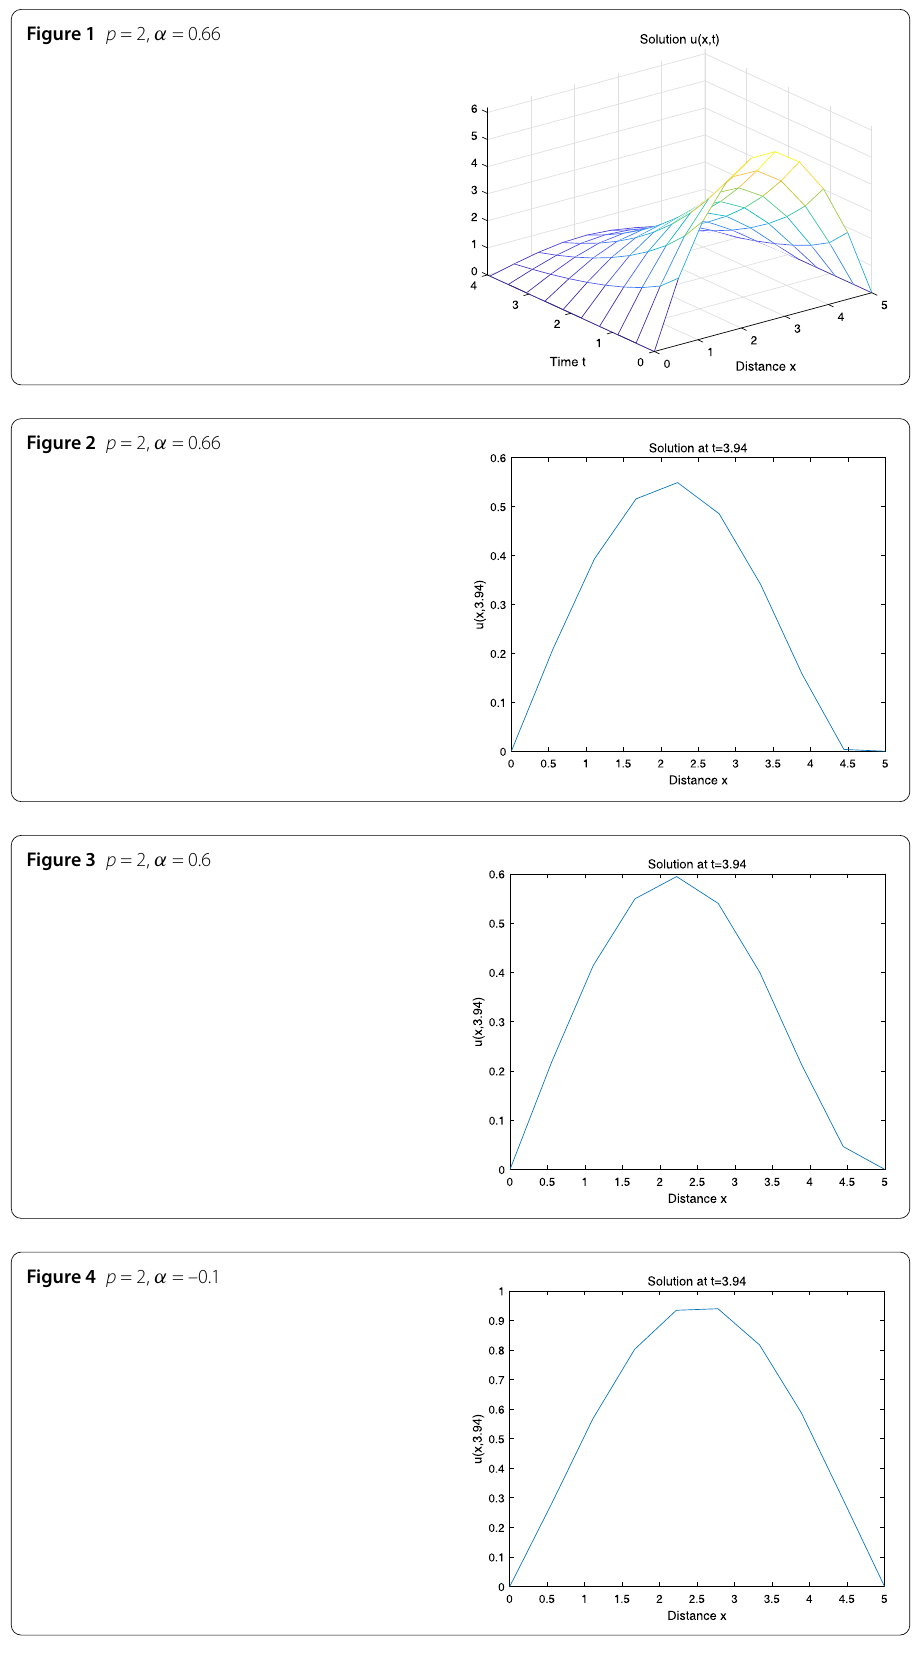
Figure 1 p = 2, α = 0.66